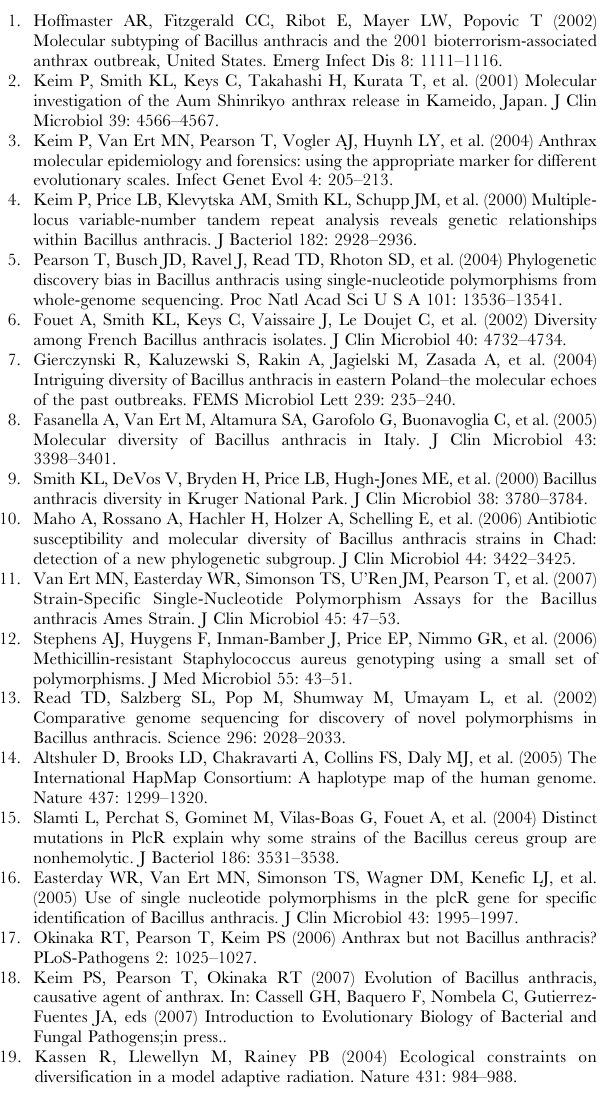
Table S6 15 VNTR loci in the B. anthracis 15 VNTR MLVA